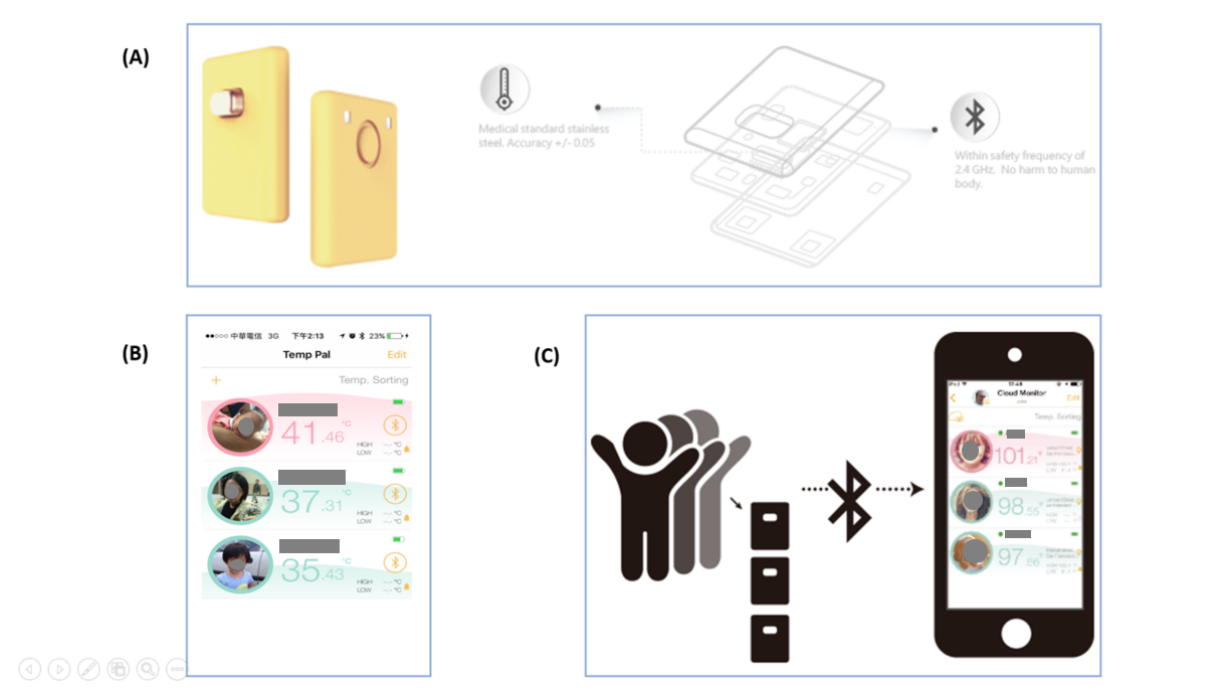
Figure 1. (A) Temp Pal body-temperature monitoring nanochip-based thermometer and app, which can (B) monitor multiple devices simultaneously and (C) transfer data via